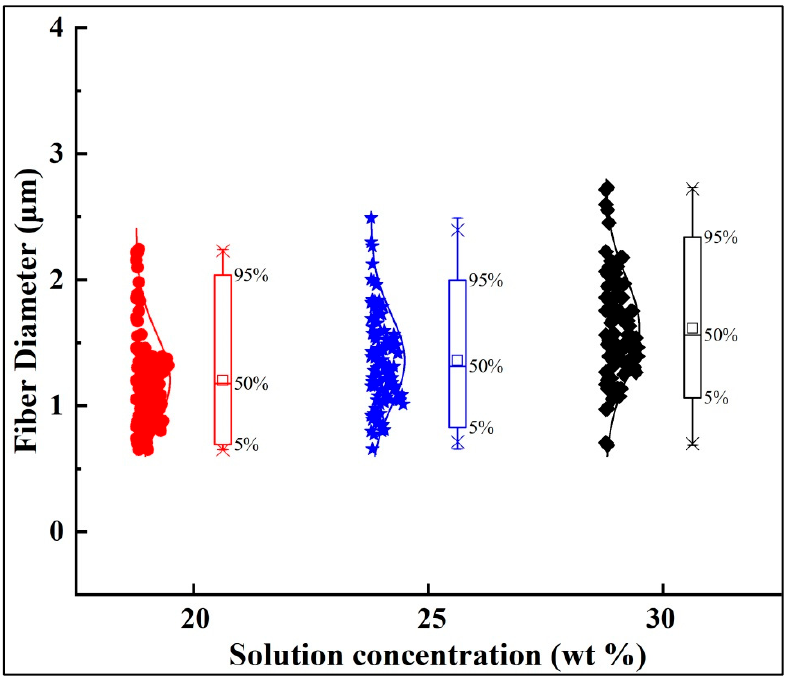
Figure 7. Diameters of fibers prepared by solutions at diverse concentrations. The processing parameters are as follows: Applied voltage of 20 kV, working distance of 20 cm, and flow rate of 1.0 mL/h.